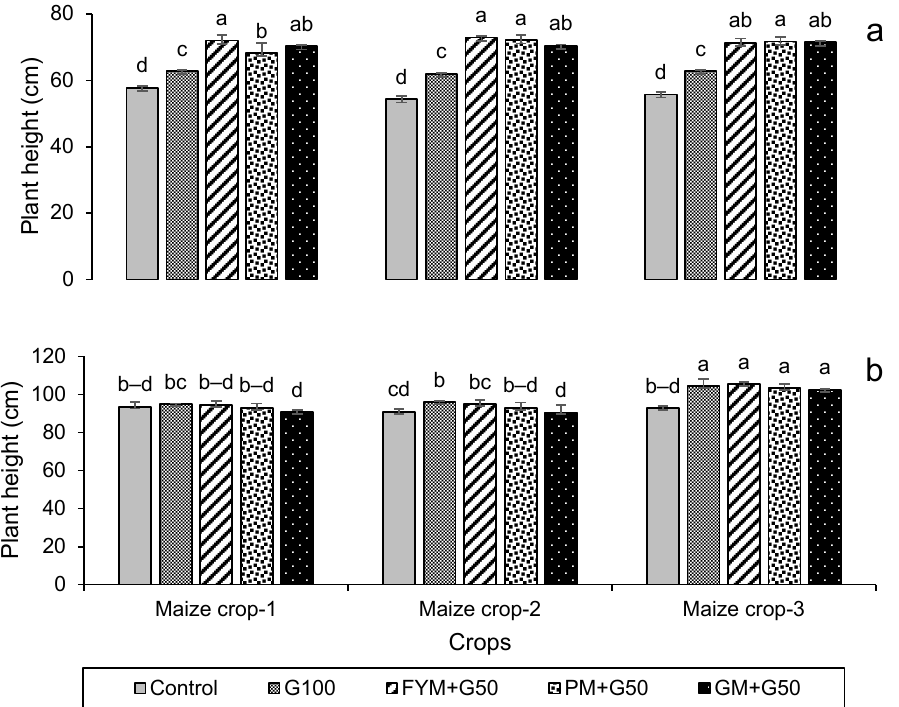
Figure 4. Impacts of different treatments on ( a ) wheat and ( b ) maize plant height. Error bars represent the standard error ( n = 3). Different letters indicate statistical difference (LSD, p < 0.05).